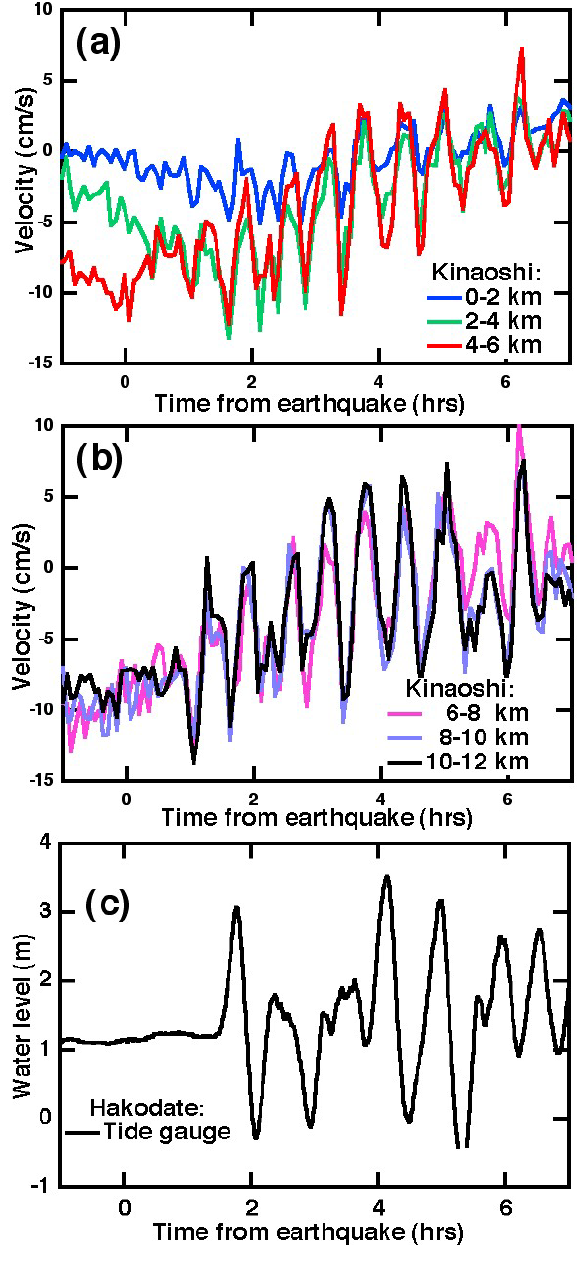
Figure 4. Time series of velocity components from the Kinaoshi radar (42 MHz transmitter frequency) and simultaneous water level observations from the Hakodate tide gauge. Radial velocity was resolved perpendicular to the shore, and averaged over bands 2 km wide parallel to the depth